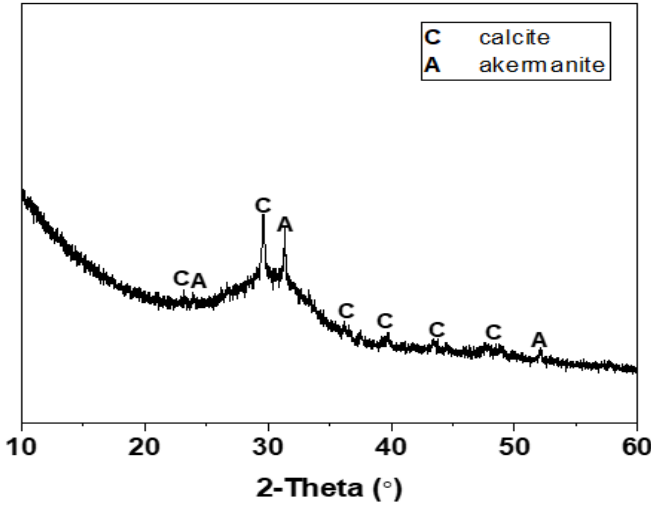
Figure 2. XRD pattern of GBFS.